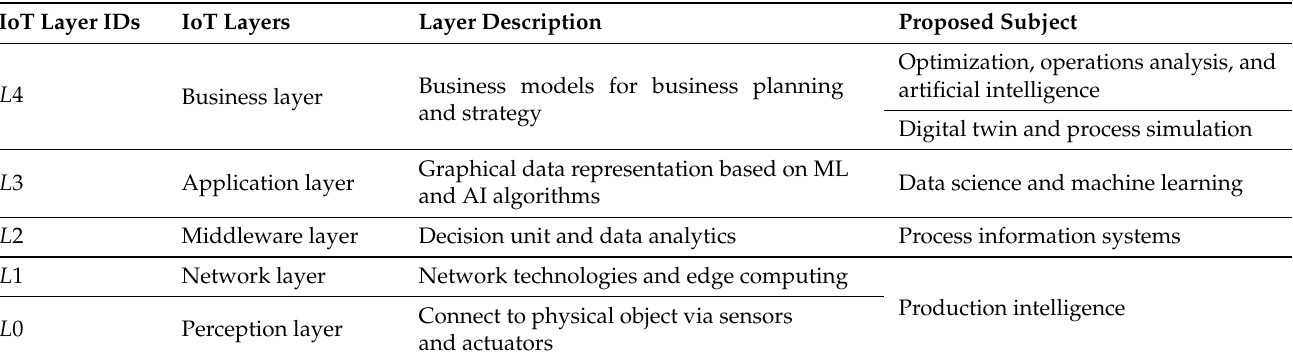
Table 2. The proposed subjects for the five levels of the